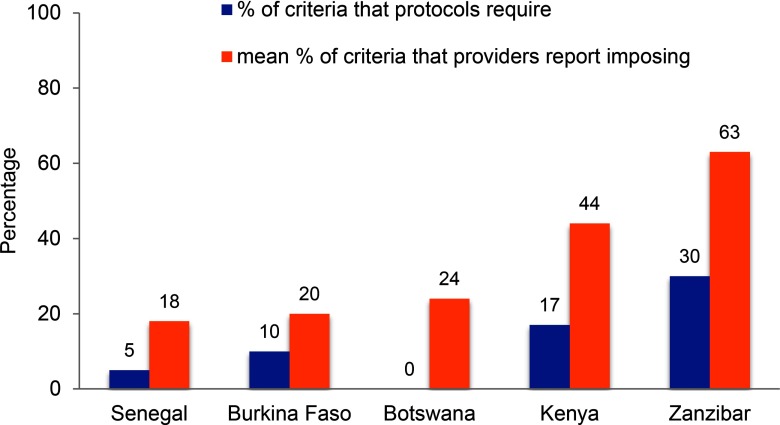
Providers Report Imposing More Eligibility Criteria Than Those Required by Protocols, Across 5 Countries